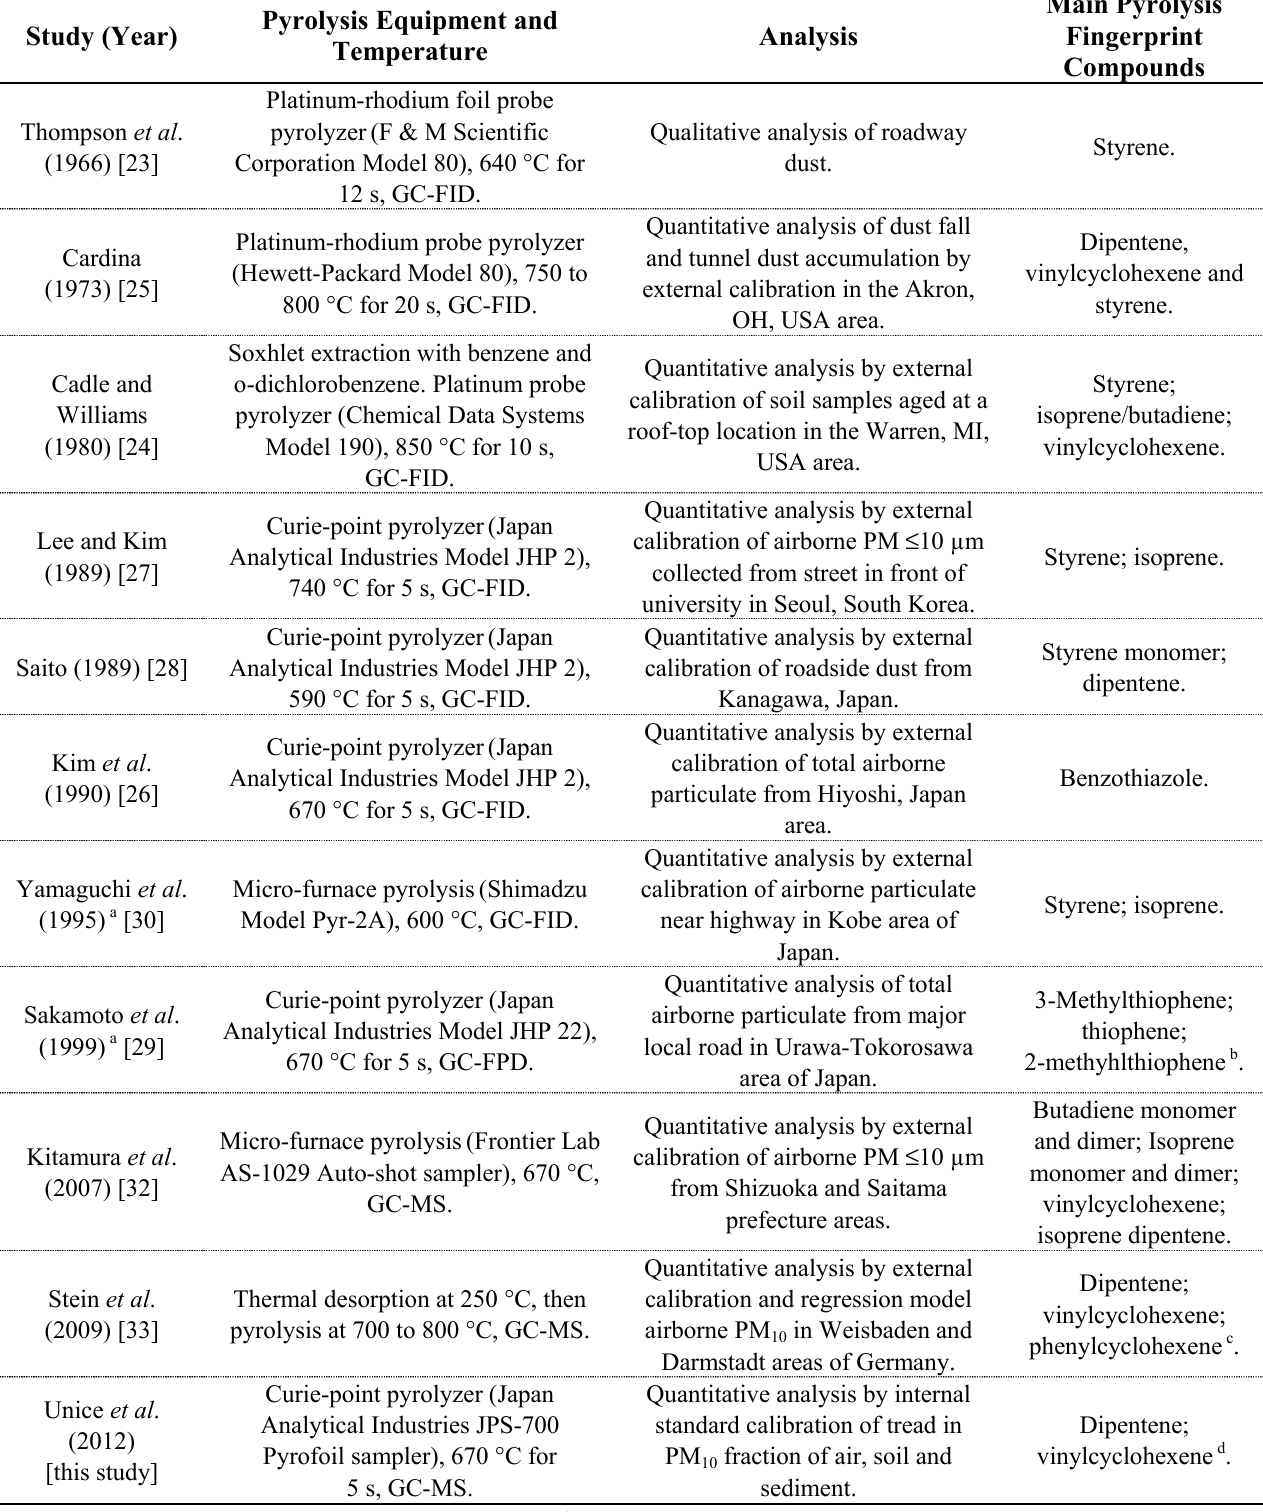
Table 1. Summary of historical applications of pyrolysis-GC analysis to measure the tire rubber content of environmental samples in chronological